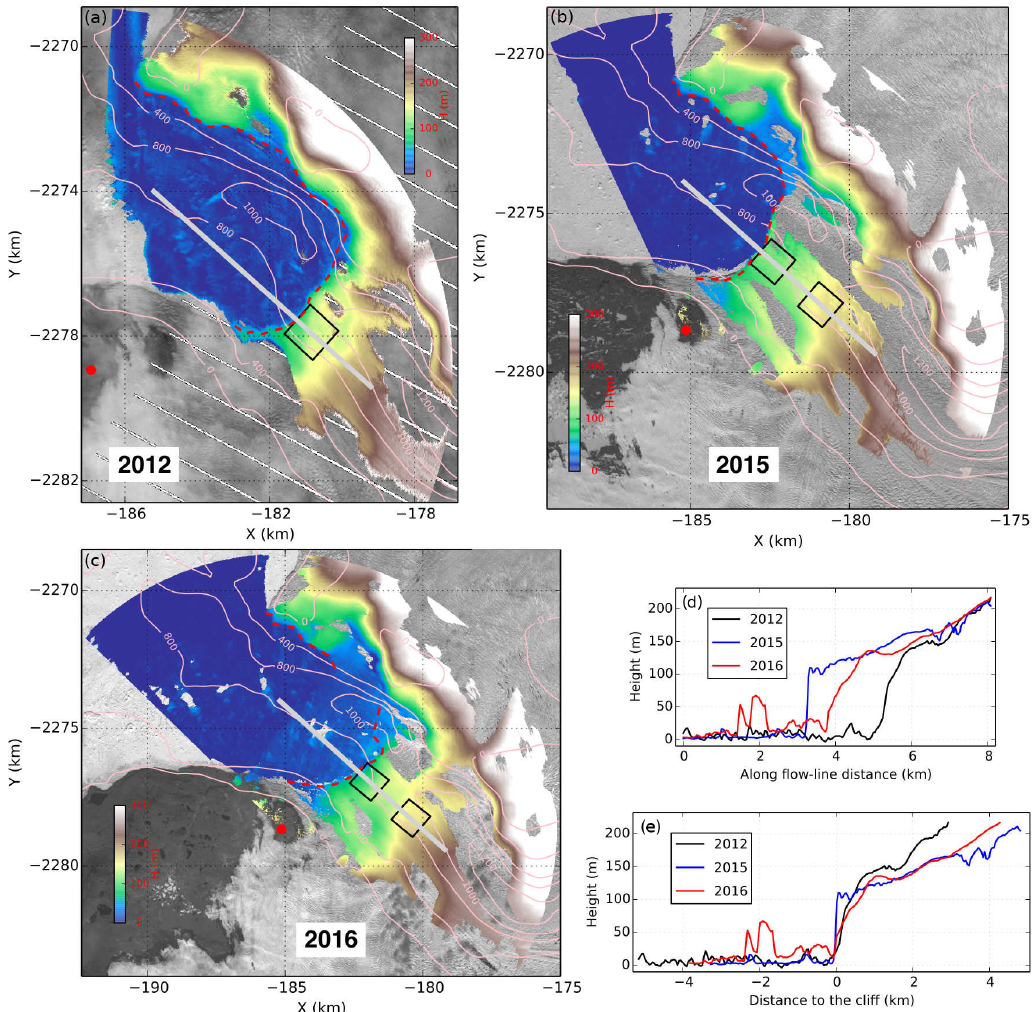
Figure 7. DEM for the glacier front, derived from median average of DEM estimates separated by 2min during a 1-day period. For each subplot, red dot shows location of the radar, and pink contours show bed bathymetry in meters (An et al., 2017). Dashed red line shows the glacier front from TRI image. Note that in 2016 it was not possible to distinguish a portion of the glacier front from TRI measurements; hence it is not marked on the map. The background image for (a) was acquired on 6 August 2012 by Landsat-7; white stripes are data gaps. Background image in (b) was acquired on 4 June 2015 by Landsat-8. Background image in (c) was acquired on 13 June 2016 by Landsat- 8. Note that uncertainty increases with distance to the radar. Mean elevation of the black box (1km × 1km outlines in a–c ) immediately adjacent to the glacier front is 99, 109, and 124m for 2012, 2015, and 2016, respectively; we use this to represent the mean elevation within 1km to the glacier front. Mean elevation of the black box upstream (1km × 1km outlines in b and c , 2–3km to the glacier front) is 154 and 158m for 2015 and 2016, respectively. Black, blue, and red line in (d) show elevation profiles along a transect marked (grey lines in a–c ). These transects have the same location in space. In (e) , the distance of each transect is normalized so that the glacier fronts are in the same